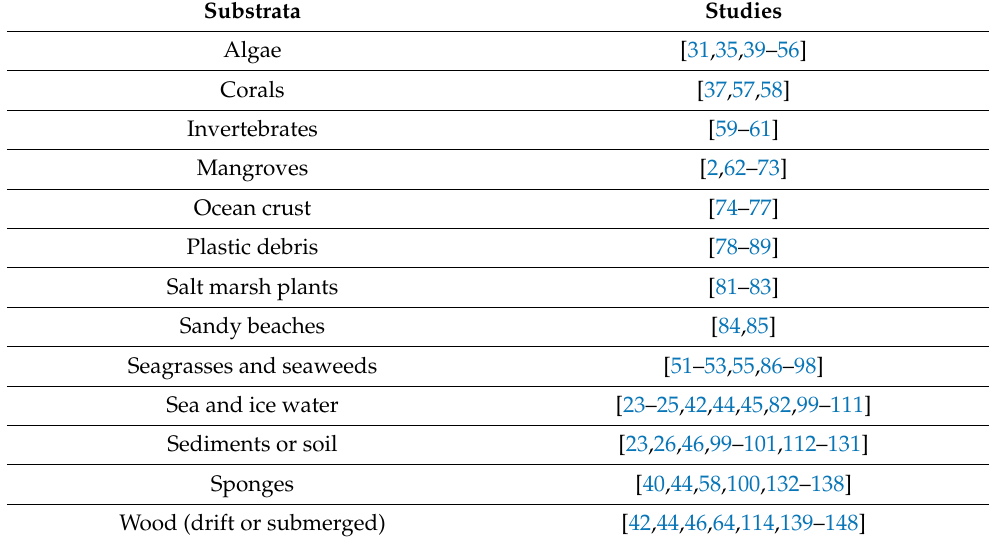
Figure 4. Diversity of marine fungal habitats. The figure was created with BioRender.com (accessed on 9 January 2022) [38]. Table 1. Substrata from which marine fungi have been identified. Only research published after 2015 were